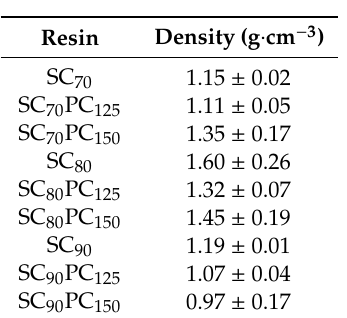
Table 3. Density of the partially bio-based epoxy resins subjected to standard curing (SC) and post-curing (PC)